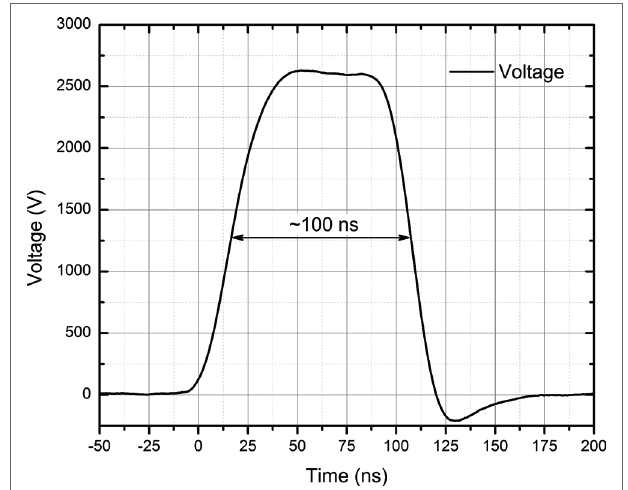
FIGURE 1 | The waveform of the shortest applied pulse (100 ns). Acquired using DPO4034 digital oscilloscope (Tektronix, Beaverton, USA), postprocessed in Origin 8.5 (Origin Lab, Northampton,